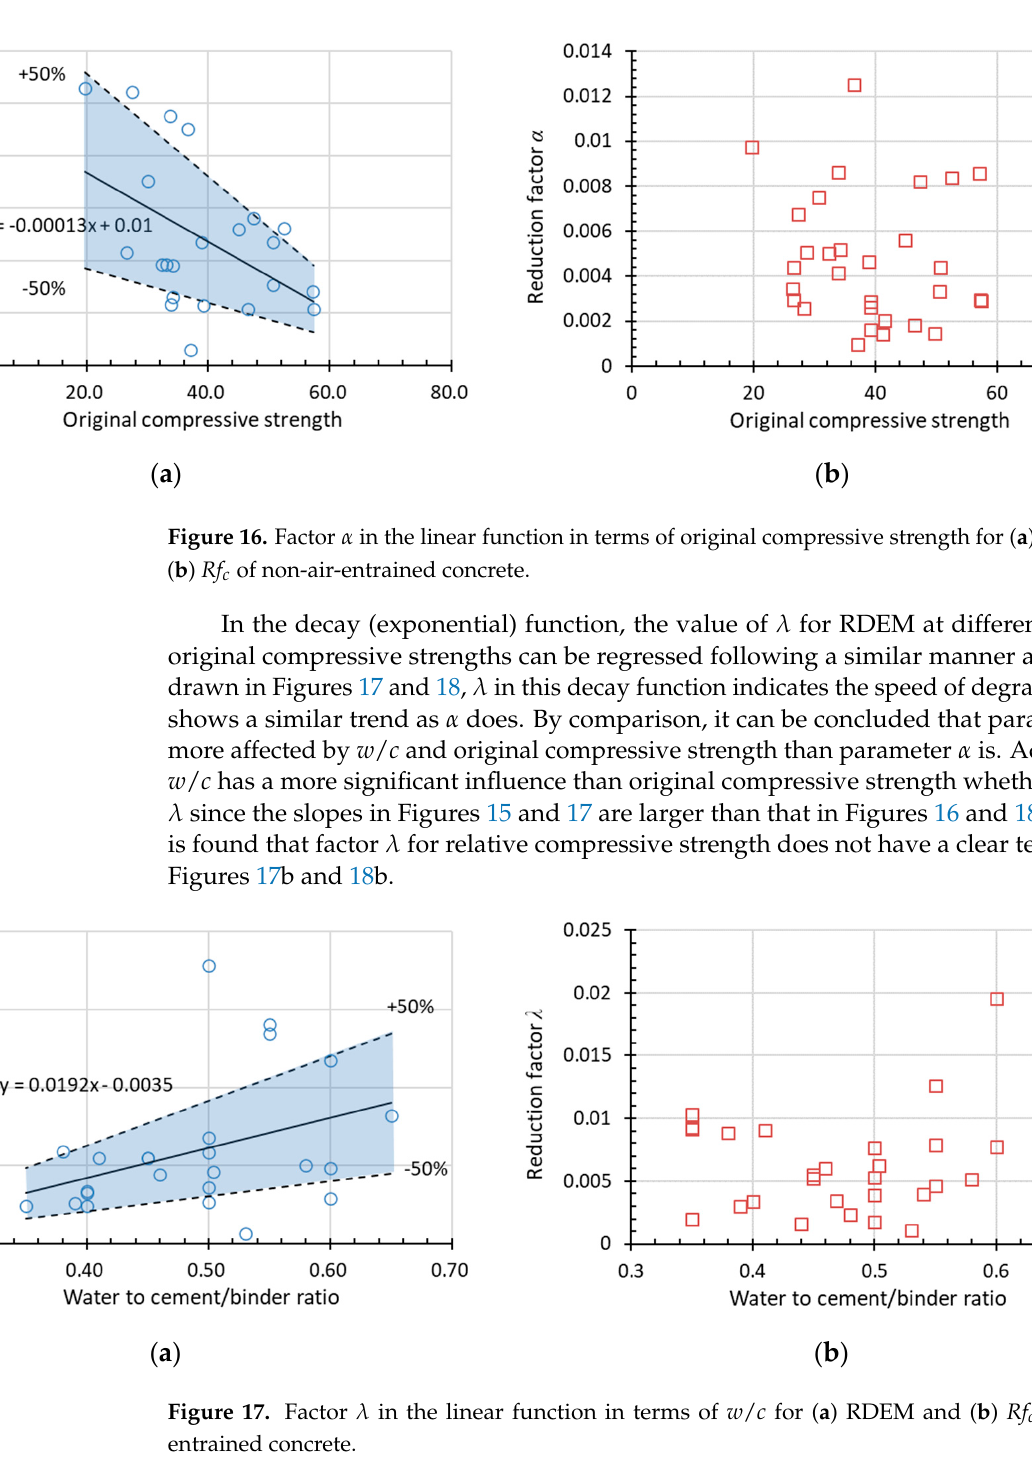
( b ) Figure 18. Factor λ in the linear function in terms of original compressive strength for ( a ) RDEM and ( b ) Rf c of non-air-entrained concrete. Satisfactory agreement could be found for most of the data. Results that fall out of the ±50% range are regarded as ineffective and thus left out of consideration. This fact strongly demonstrates the applicability of the proposed models. 3.2.3. Influencing Factors on Deterioration Speed (1) Effect of w / c ratio According to Gong et al. [64], different water-to-cement ratios may lead to consider- able influence on the pore size distribution of cementitious materials, thus affecting the ice formation process during freezing–thawing cycles. A higher w / c ratio means a larger proportion of capillary pores and a bigger volume of ice formation during freezing. As shown in Figure 19, a larger w / c ratio leads to a higher value of factor α (except for Fu’s results), suggesting that faster damage accumulation takes place in concrete materials. The value of α varies greatly with w / c ratios, and even the same w / c ratio (e.g., w / c = 0.6) yields values of α that are poles apart in different studies. This indicates that there are other factors that influence α at the same time. Comparing Figures 17 and 19, it further proves that the experimental data from the individual study are scattered due to the dif- ferent material properties and freeze–thaw conditions by the standard. Therefore, it is rea- sonable to put sufficient test data to empirically model the reduction factor instead of adopting only specific data.